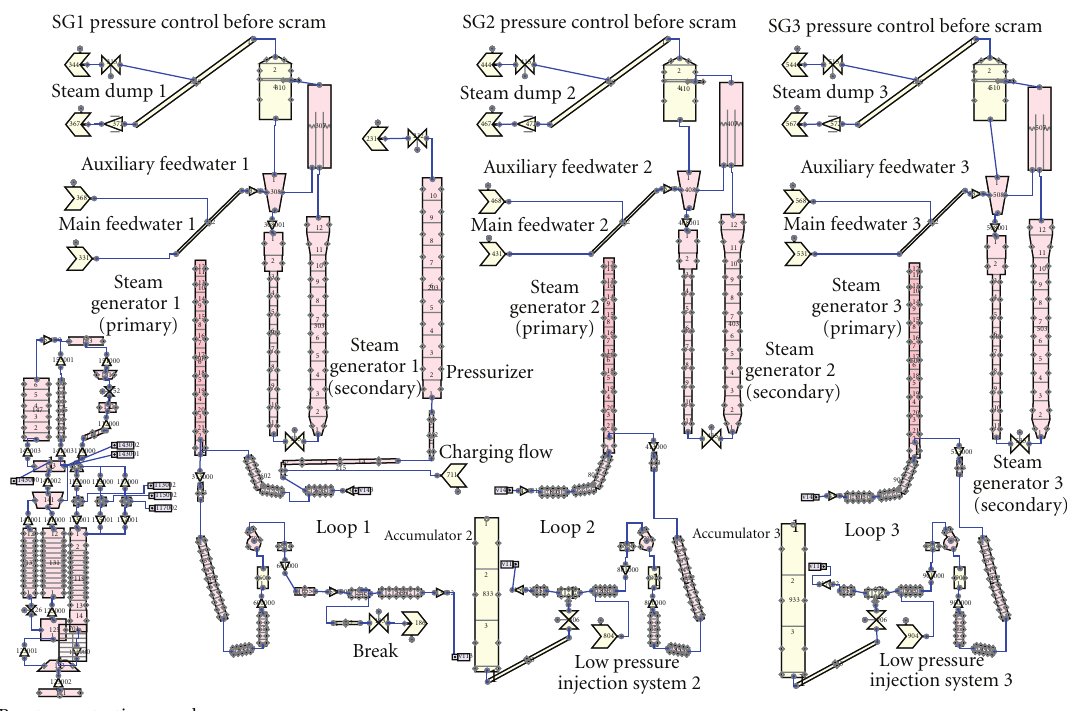
pressure control before scram